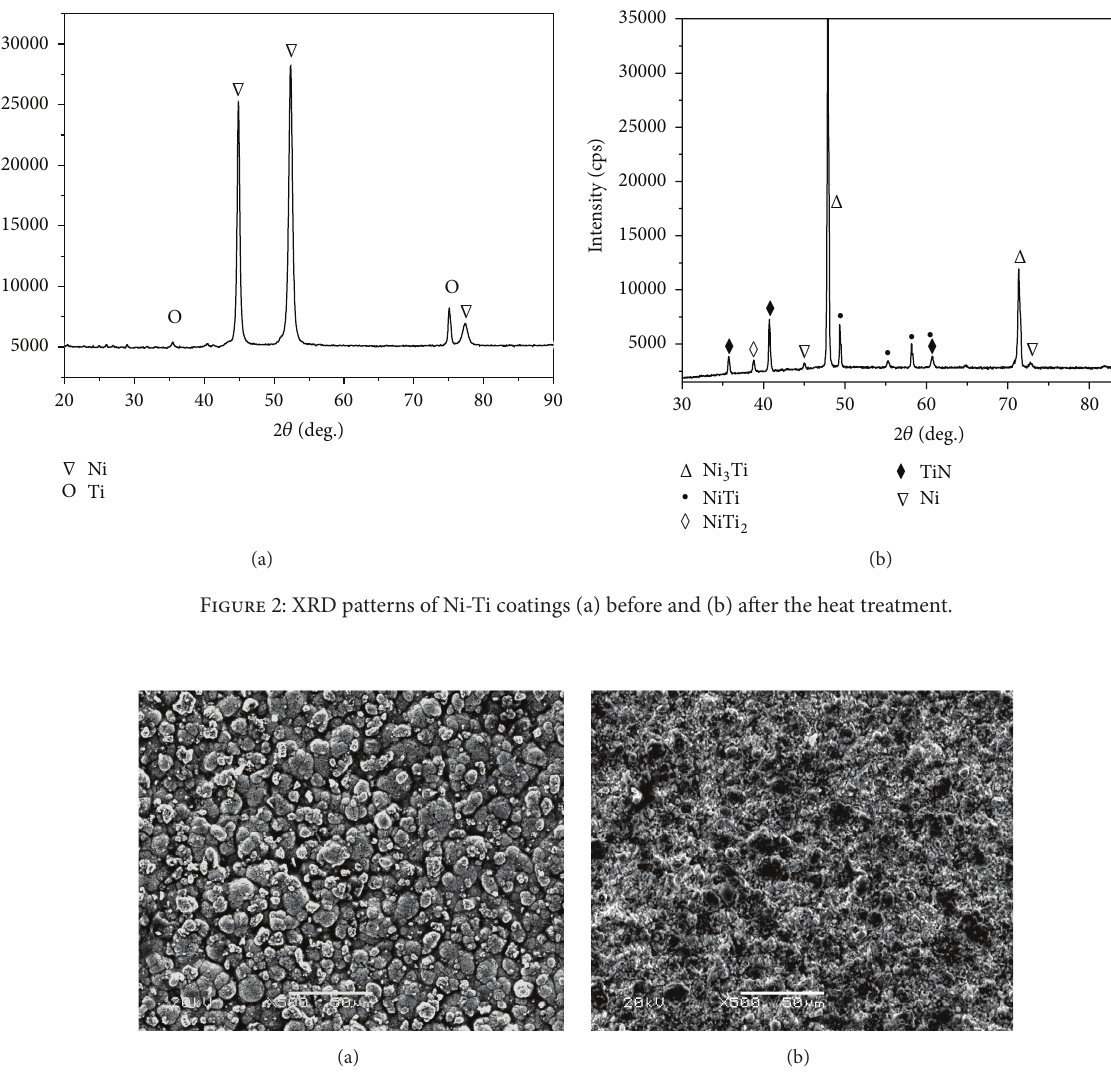
Figure 3: SEM micrographs of Ni-Ti coatings before heat treatment (a) and after heat treatment (b) under the same magnification (zoom in ×